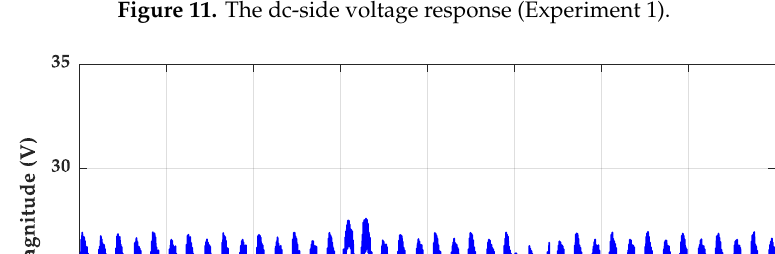
Energies 2019 , 12 , x FOR PEER REVIEW Figure 11. The dc-side voltage response (Experiment 1). Figure 11. The dc-side voltage response (Experiment 1).